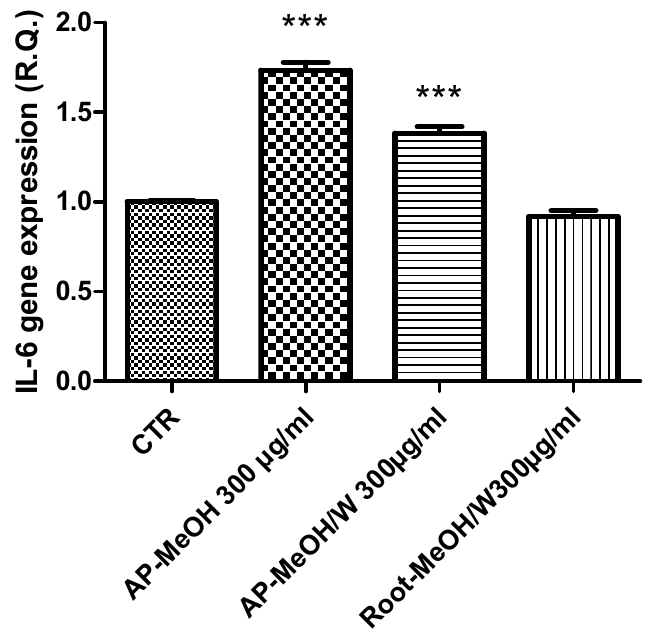
Figure 6. Stimulatory effects of IL-6 gene expression induced by the methanol (MeOH) and methanol/water (MeOH/W) extracts of aerial parts (AP) and roots from Epilobium hirsutum (100–300 µg/mL). ANOVA, p < 0.0001, *** p < 0.001 vs. CTR (Control) group.